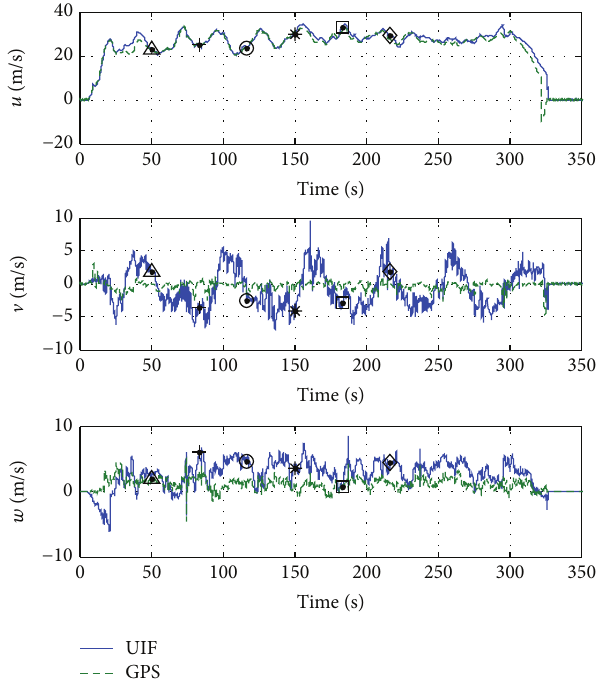
Figure 5: Estimated velocity components for Flight #1.